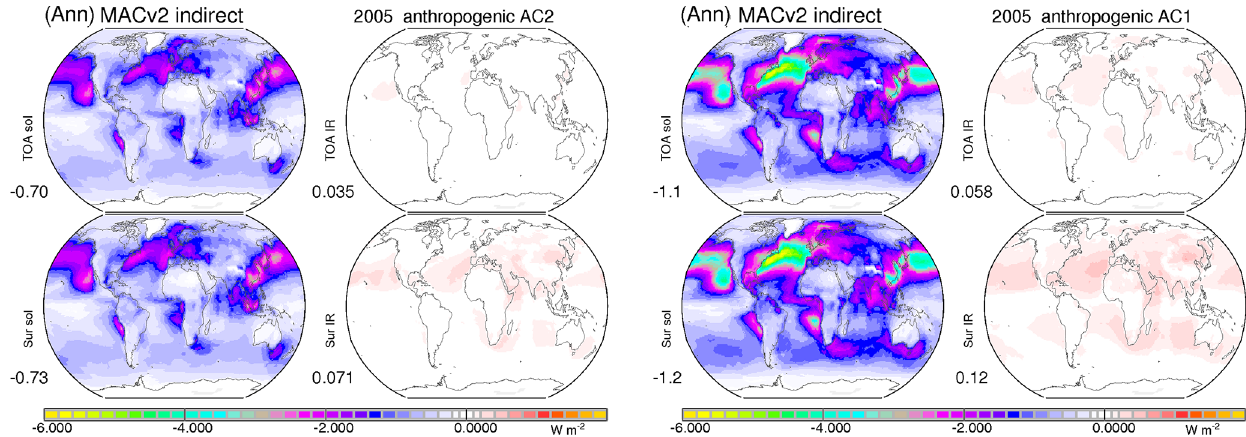
Figure 12. Annual maps of indirect (Twomey) effects for present-day anthropogenic aerosol based on year 1850 anthropogenic fine-mode fractions of AeroCom 2 (left frame) and on 1750 anthropogenic fine-mode fractions of AeroCom 1 (right frame). Compared in each block are solar (left column) and infrared (right column) radiative effects at the TOA (top row) and at the surface (bottom row). Blue colors indicate a cooling and red colors a warming. Values below the labels are global averages.